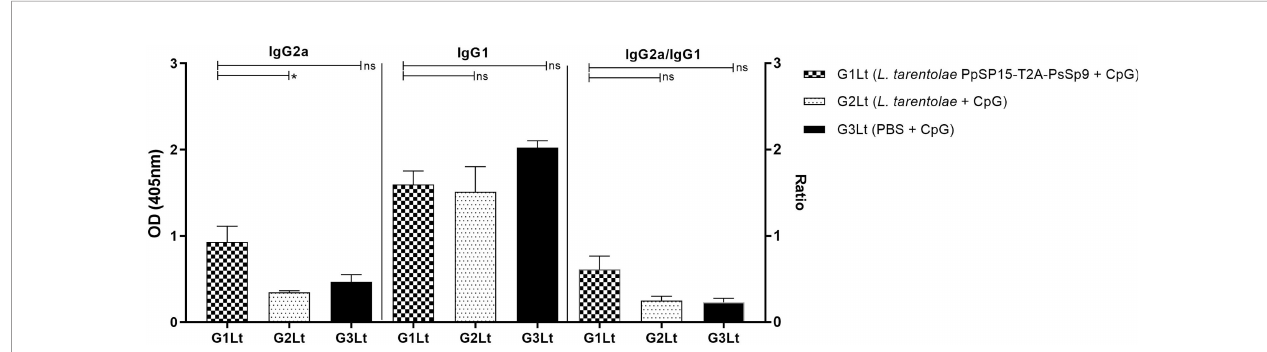
FIGURE 9 | Analysis of antigen-speci fi c antibody responses in vaccinated and control groups. The sera were collected from all mice (n=8 mice per group) at week 11 post-challenge and the levels of IgG2a, IgG1, and IgG2a/IgG1 ratio were evaluated in response to L. tropica F/T antigen. Data are representative of two independent experiments. The results are presented as mean ± SE and student t-test was used for statistical analysis (* P < 0.05; ns, non-signi fi cant).